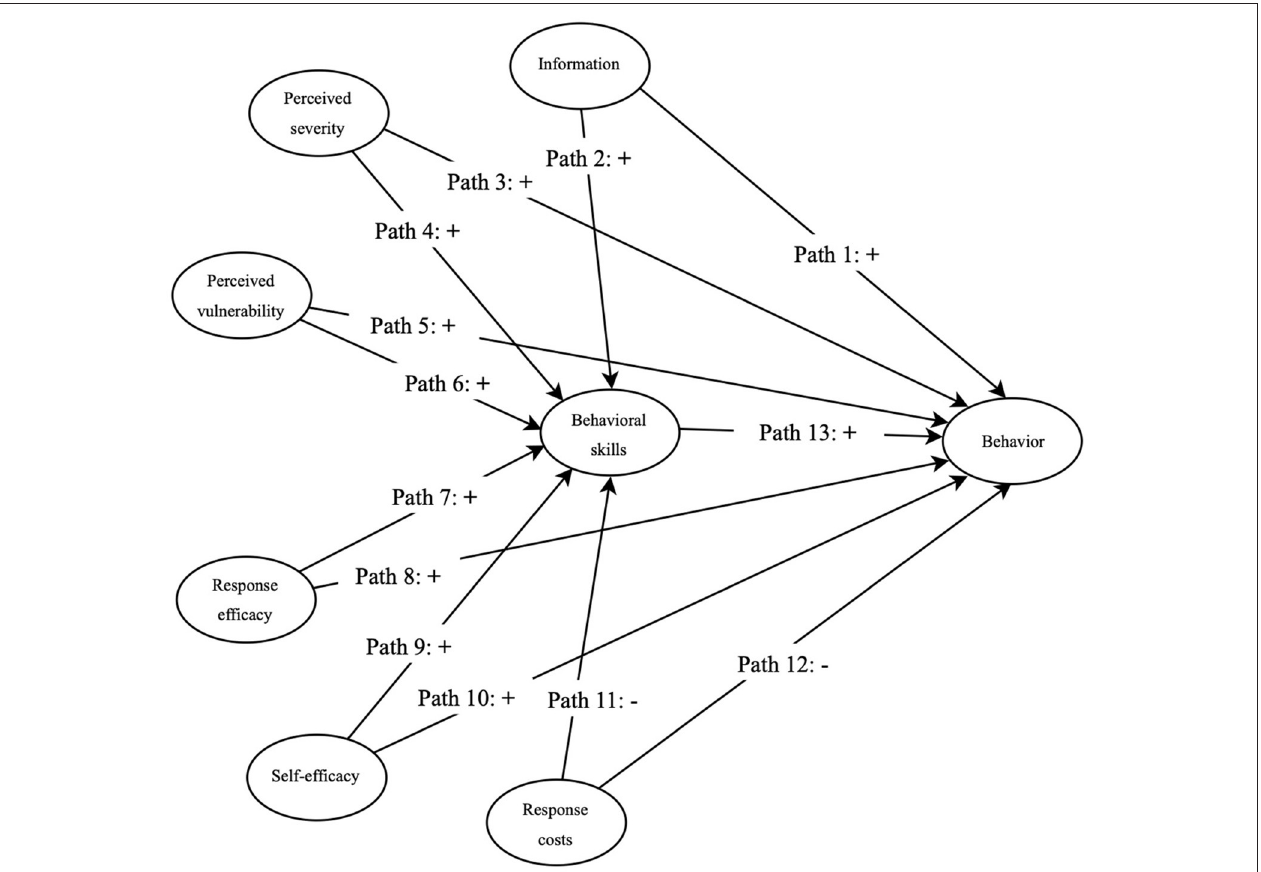
FIGURE 1 | The PMT-IMB model. Behavior, behavior during